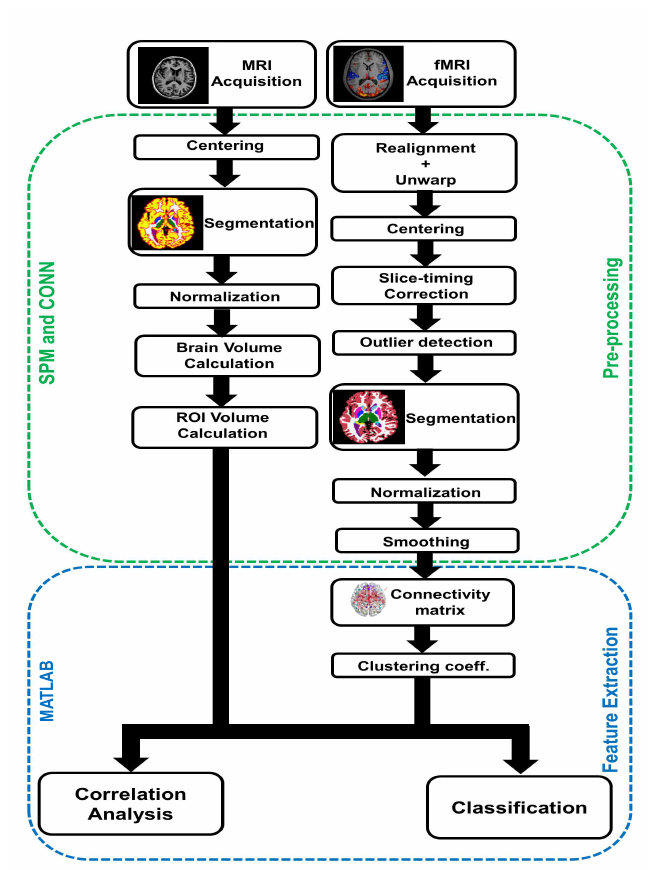
Figure 1. Preprocessing and elaboration steps for MRI and fMRI